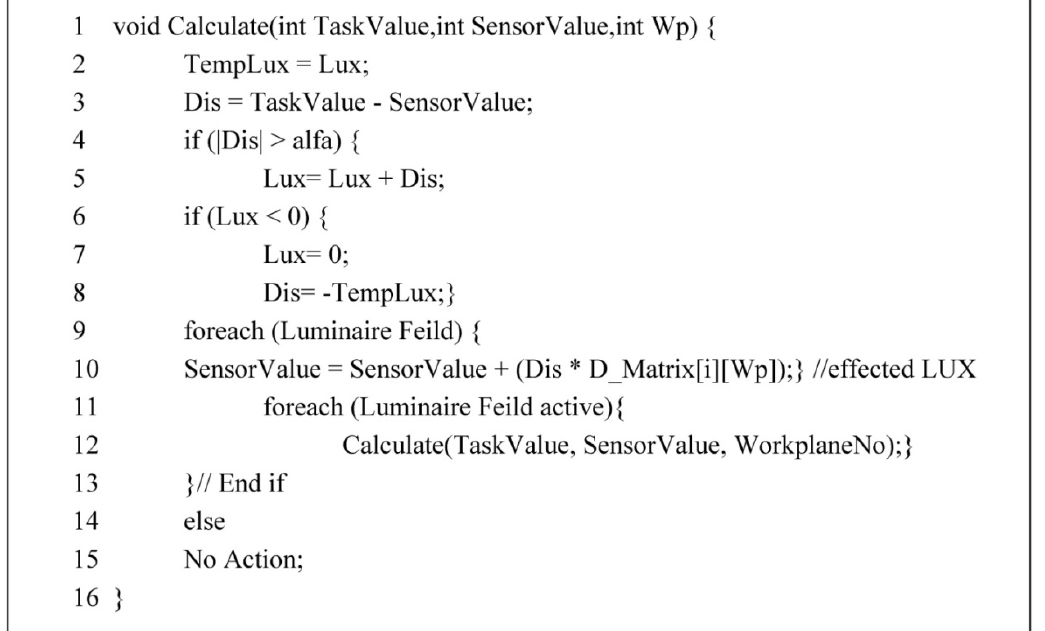
Figure 7. Pseudo code of Lighting Decision